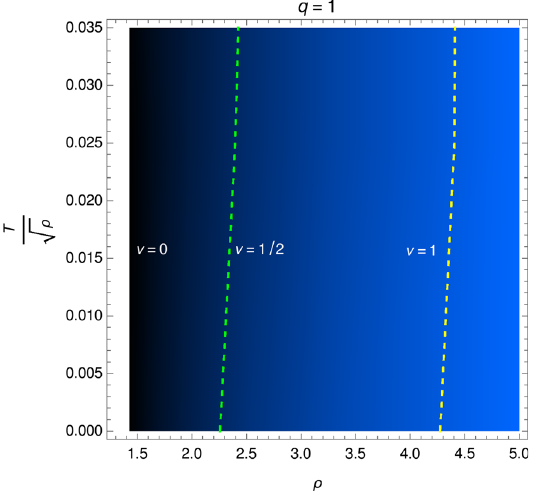
(b) Height of A ( ω = 0 , k = k F ) vs. 1 /ρ √ ρ =0.025. √ for q = 1 and T/ ρ vs. ρ plane for q = 1. ( a ) T/ √ ρ vs. ρ plane. The colour gra- Fig. 6 Left: Density plot of ν in T / low dashed lines correspond to ν = 1 / 2 and ν = 1 respectively. Right: dient corresponds to the value of ν which increases from left to right. Height of the spectral function decreases exponentially as the system The white portion is the oscillatory region with darkest shades being move from Fermi toward the non-Fermi ν = 0 and gradually increase with the lighter shade. The green and yel-